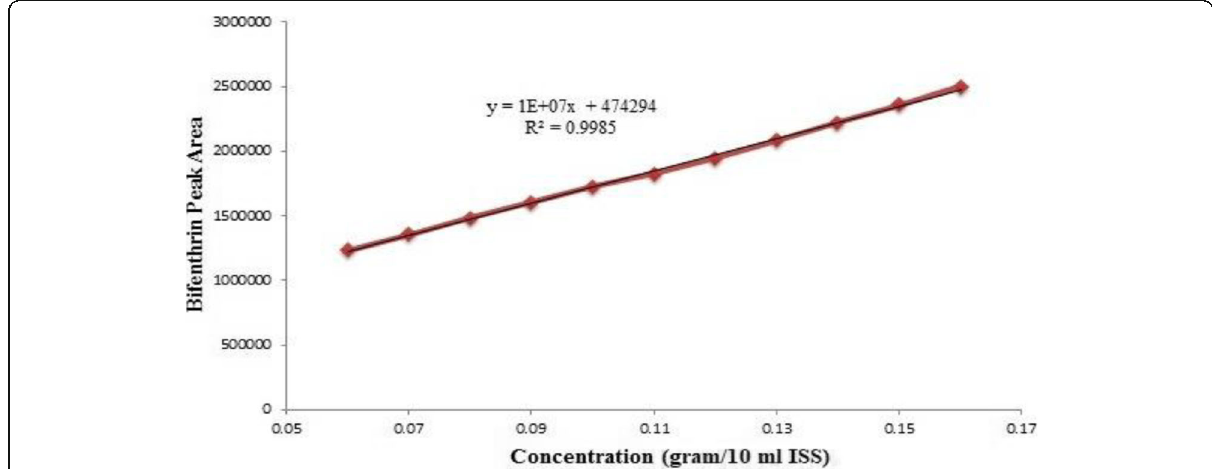
Fig. 3 Linearity graph showing the relation of bifenthrin concentration and peak